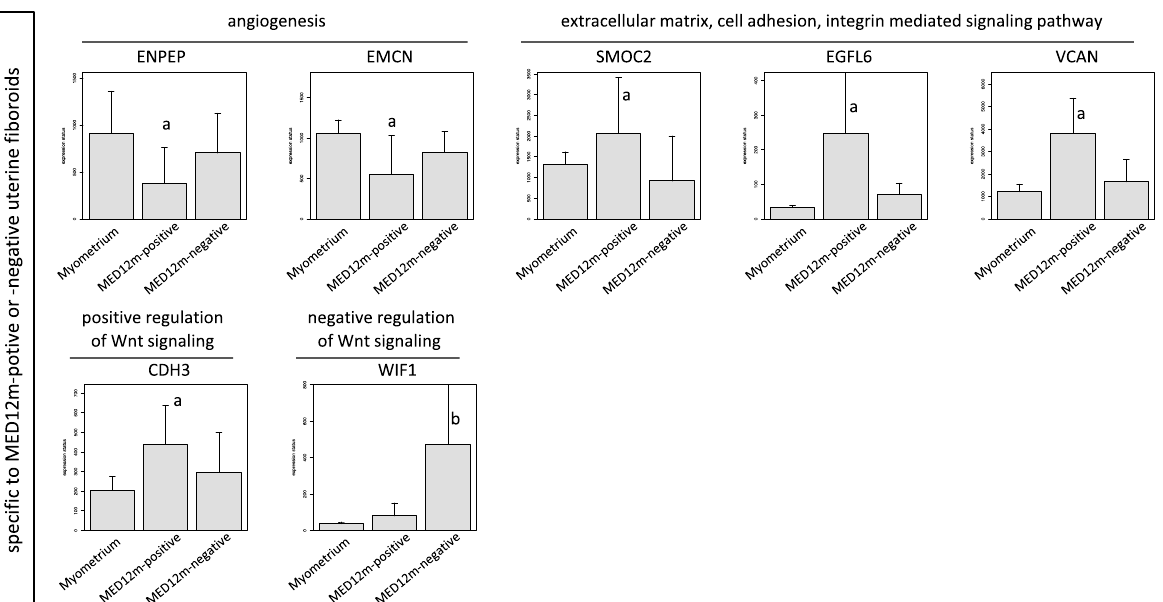
shows the specific GO terms from three COG groups in the MED12m-positive (Group1, Group2, and Group3) and five COG groups in the MED12m-negative (Group1, Group2, Group3, Group4, and Group5), respectively. The commonly detected GO terms between the MED12m-positive and -negative uterine fibroids included "RNA splicing, via transesterification reactions", "mRNA splicing, via spliceosome", "ncRNA processing", "mRNA